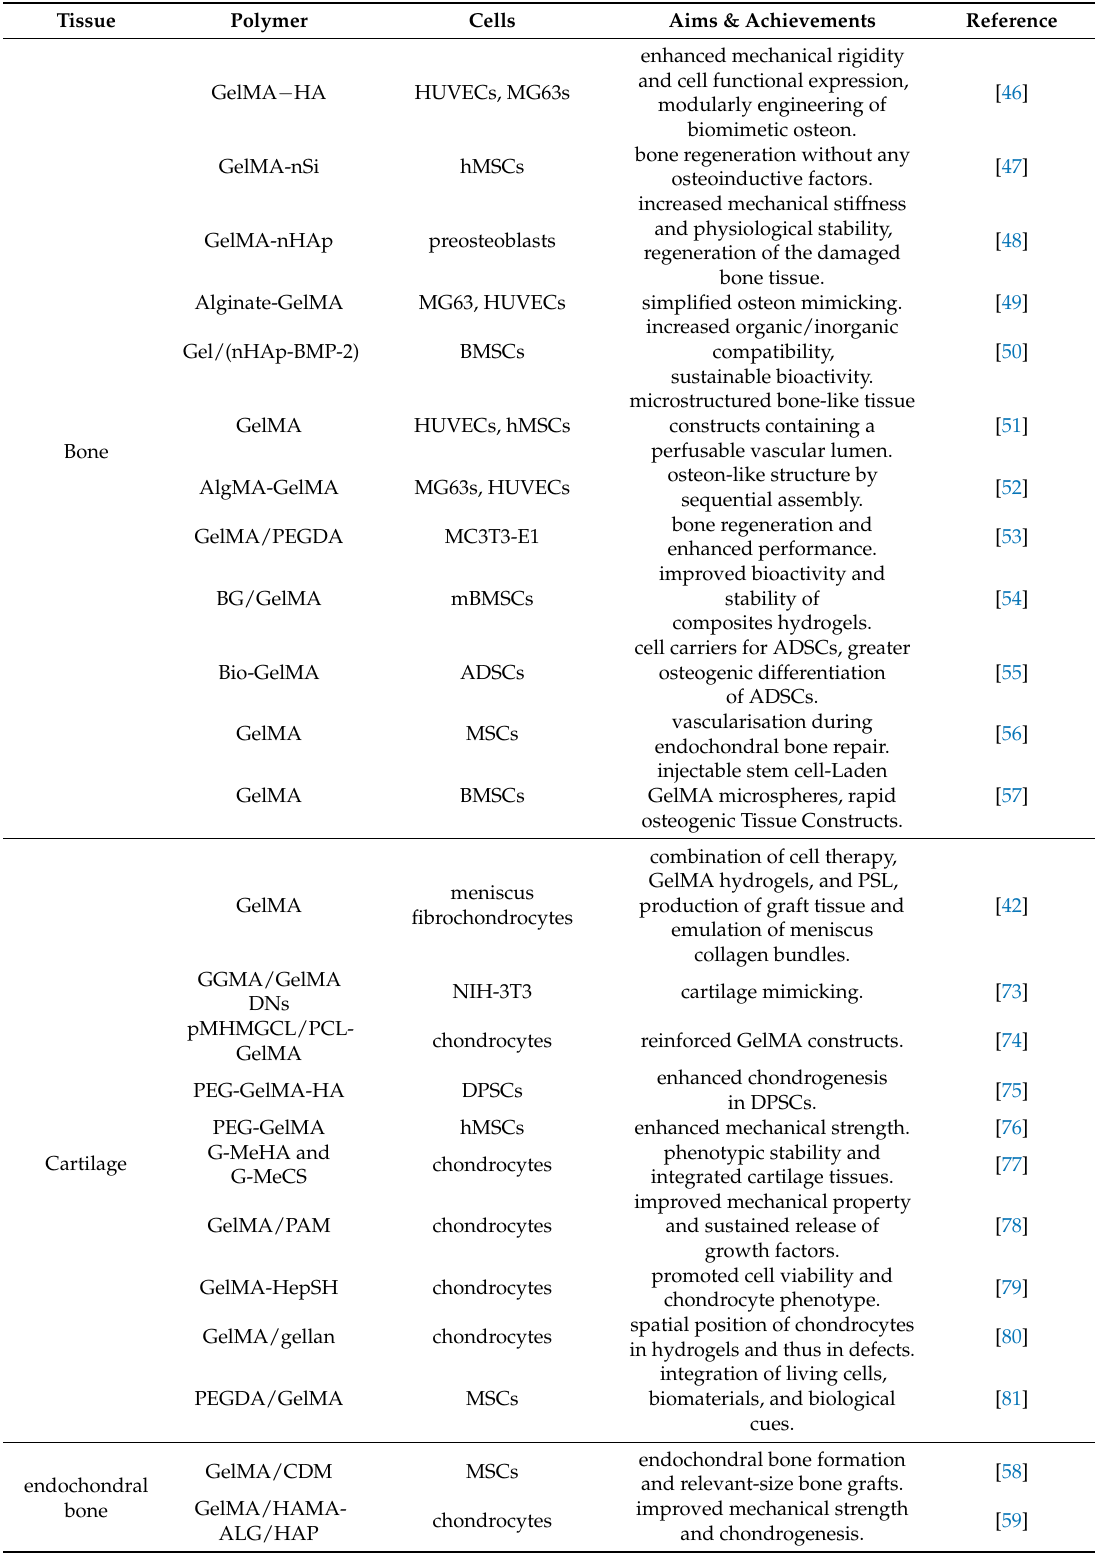
Table 1. A summary of researches on GelMA hydrogels in load-bearing tissue and its related tissue.